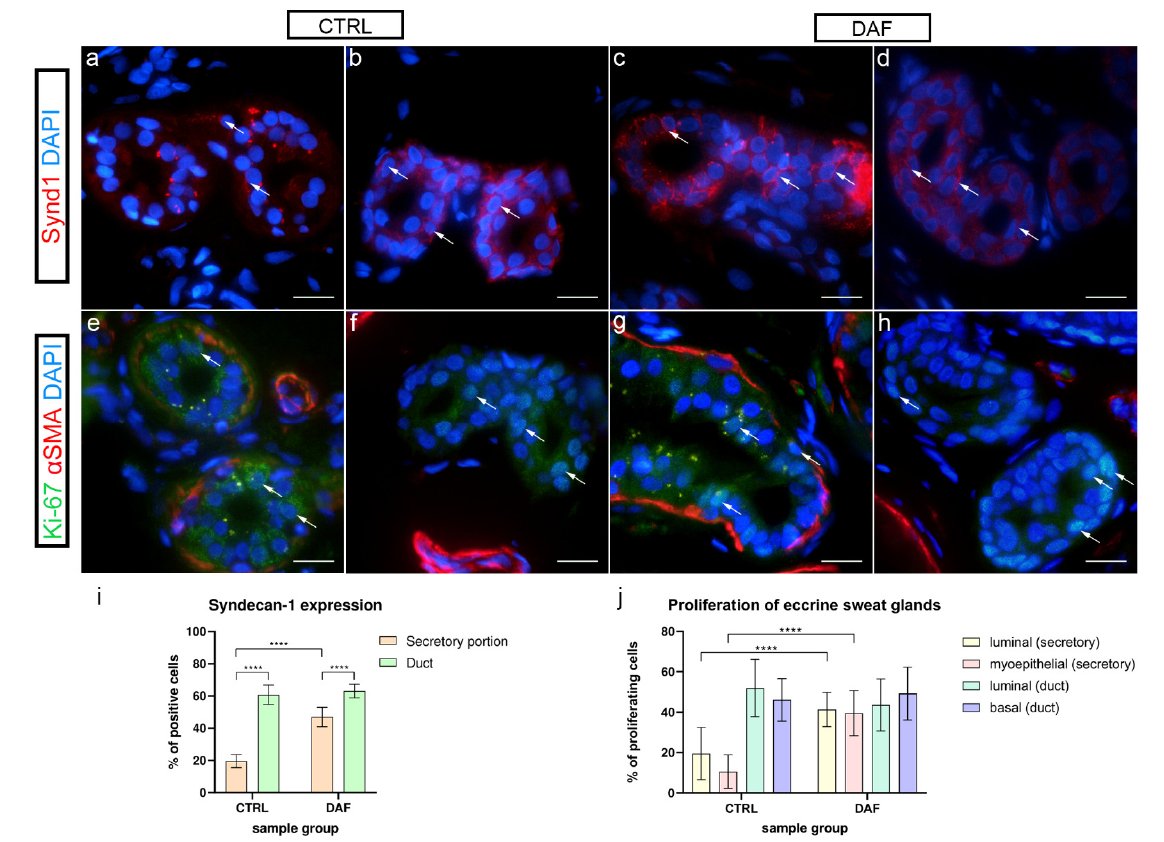
Figure 7. Expression of syndecan-1 and co-expression of Ki-67 and α -SMA in eccrine sweat glands of healthy controls and patients with DD. CTRL–normal skin of healthy individuals ( a , b , e , f ); DAF– clinically affected palmar fascia of DD patients ( c , d , g , h ). Syndecan-1 expression is seen in eccrine sweat gland cells (arrows) of secretory portions ( a , c ) and ducts ( b , d ). Nuclear Ki-67 expression is also seen in eccrine sweat gland cells (arrows) of secretory portions ( e , g ) and ducts ( f , h ); α -SMA staining shows myoepithelial cells of sweat gland secretory portions and sections through surrounding blood vessels ( e – h ). DAPI staining displays all cell nuclei ( a – h ). Immunoflu- orescence staining to syndecan-1 and DAPI, and double immunofluorescence staining to Ki-67, α -SMA, and DAPI, 1000 × magnification, scale bar 50 µ m. Statistically significant differences in syndecan-1 expression ( i ) and proliferation rate ( j ) are displayed by graphs. Error bars show standard deviation; **** p <